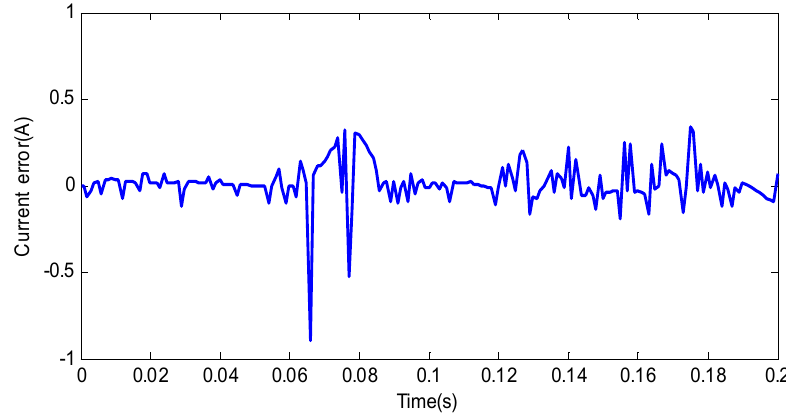
Figure 8. Current errors using the BP networks.